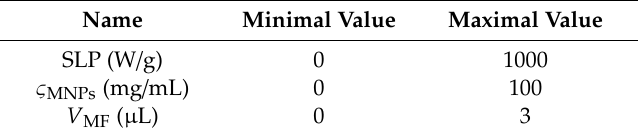
Table 4. Safe ranges of SLP, injection volume ( V MF ) and concentration ( ς MNPs ) values for